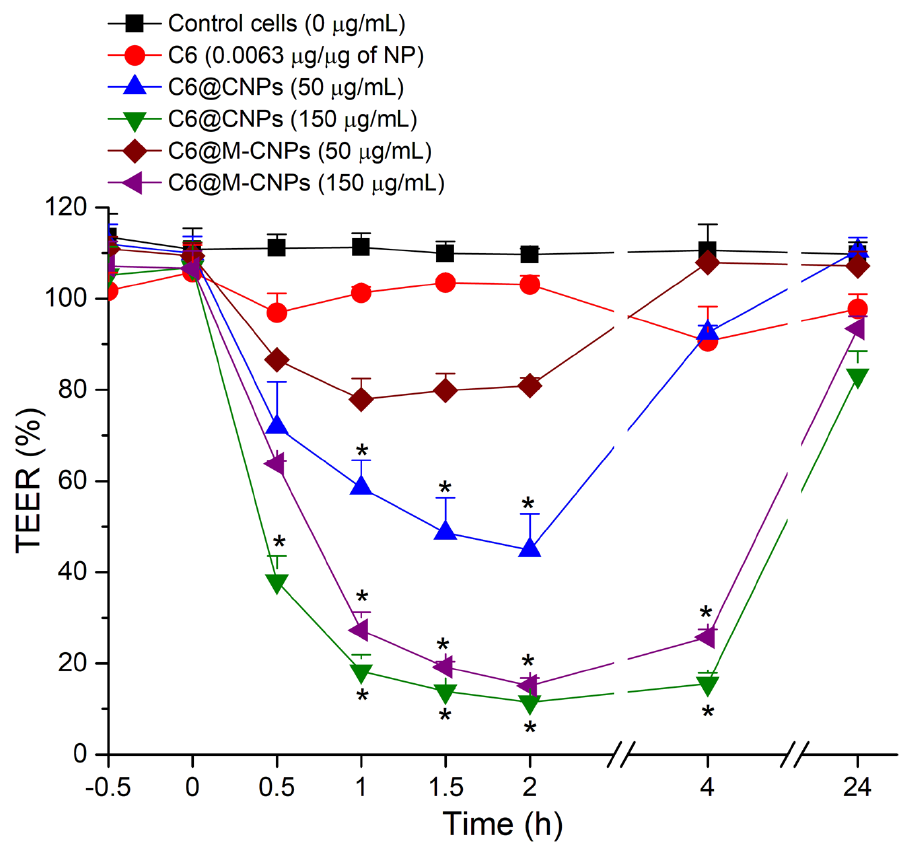
Figure 8. TEER measurements of the Caco-2 monolayers exposed to C6@CNCs and C6@M-CNCs (50 and 150 µg/mL). Results were expressed as % of negative control (0 µg/mL) and are shown as mean ± SEM ( n = 3). Data points significantly different ( p < 0.05) from negative control (0 µg/mL) are marked with an asterisk.